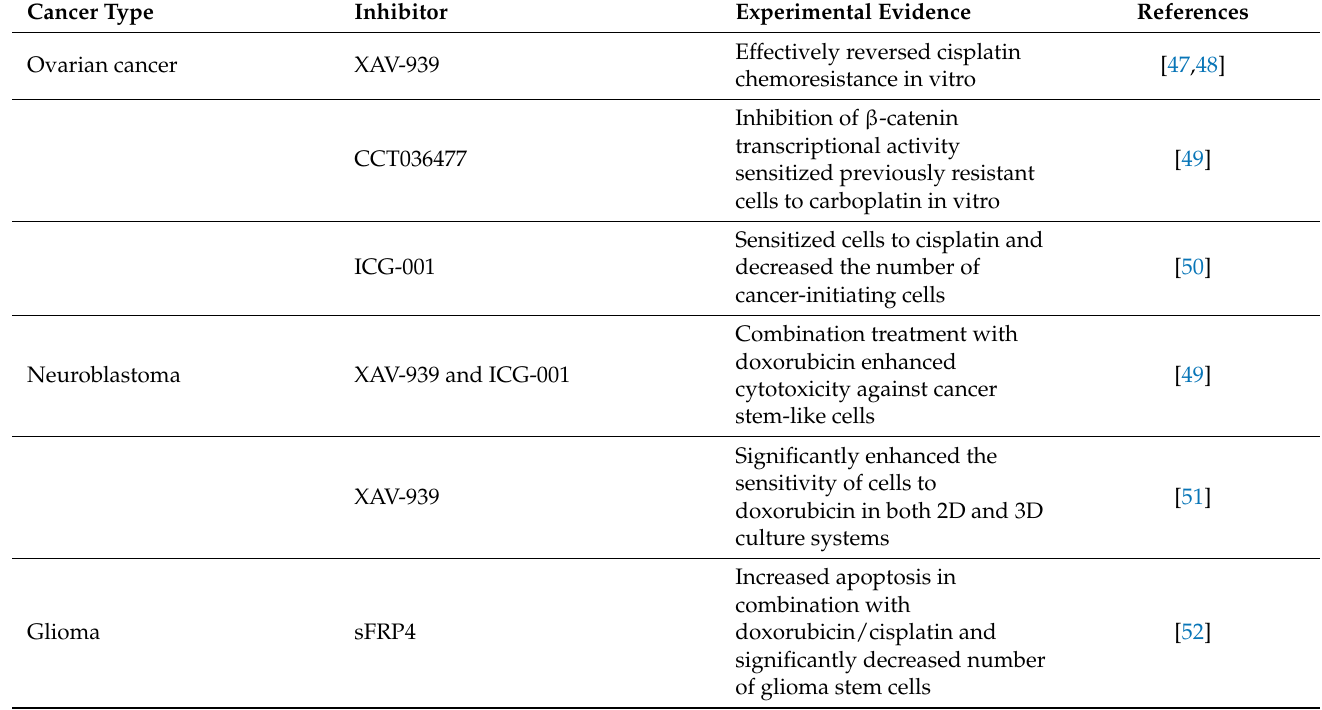
Table 2. Summary of evidence for the role of Wnt signaling in chemoresistance of cancer stem cells. Cancer